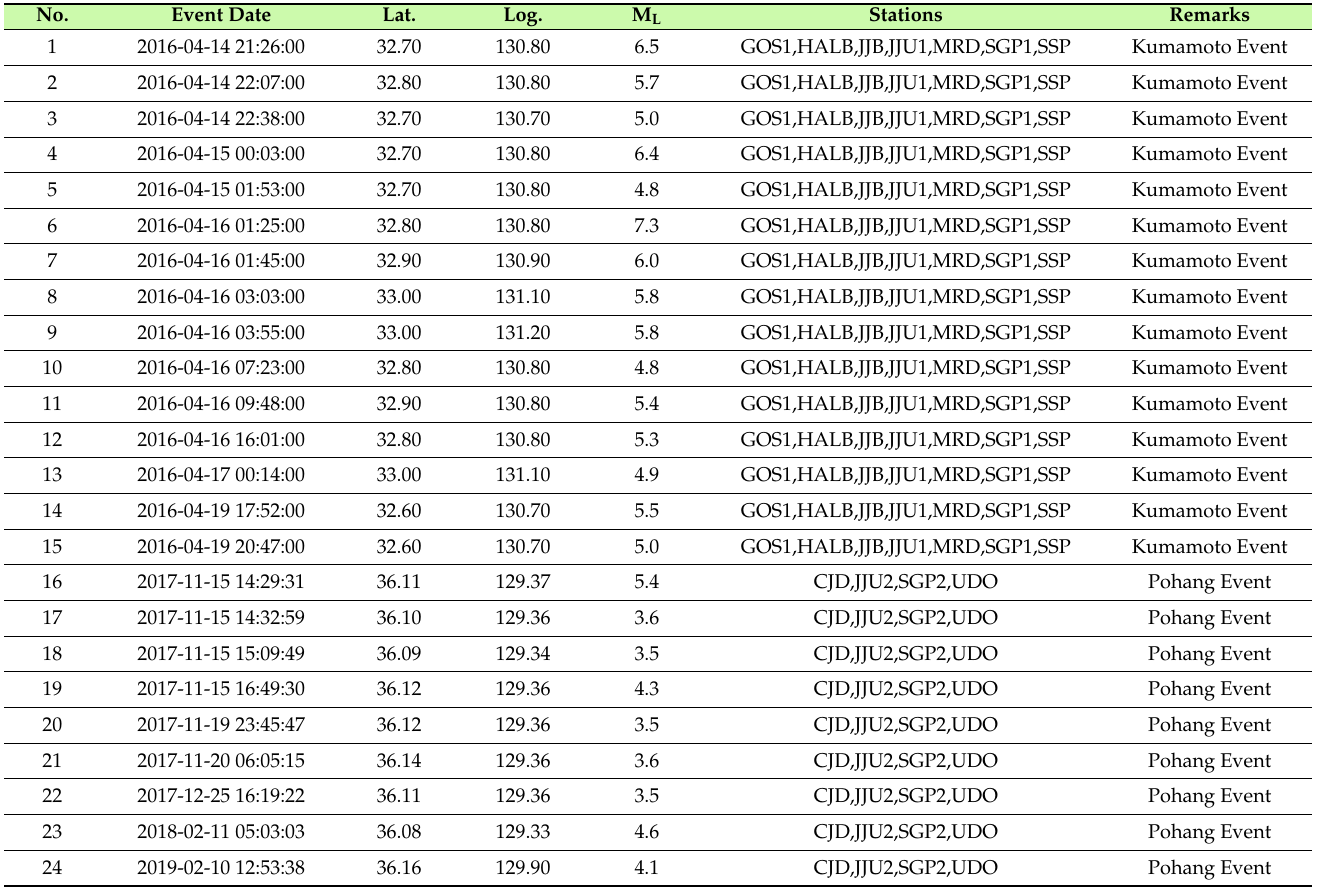
Table 1. Dates and seismic stations of earthquake